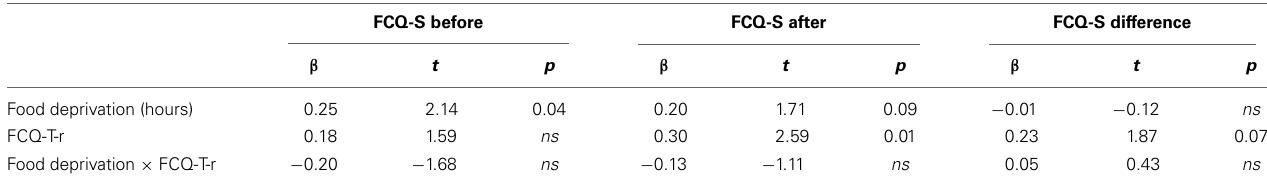
Table 5 | Regression analyses for predicting state food craving by food deprivation and scores on the Food Cravings Questionnaire—Trait—reduced